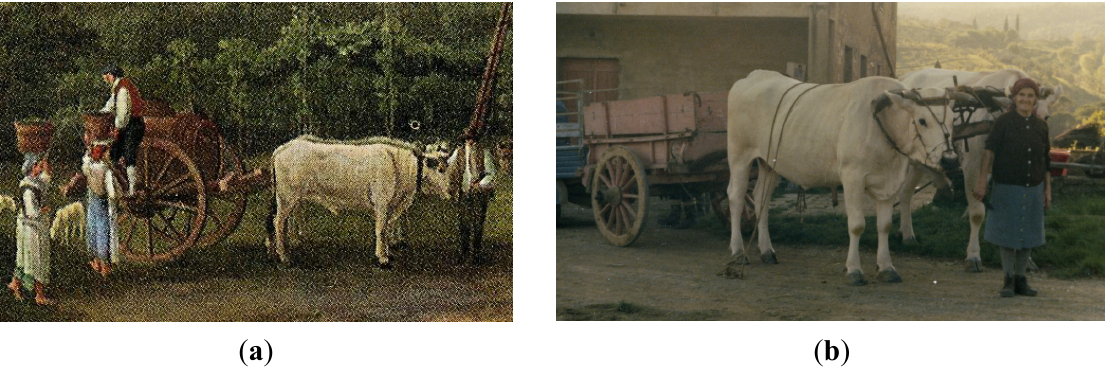
Figure 18. Chianina draught cattle. ( a ) The Autumn , Jacob Philipp Hackert, painted ca. 1784 in Italy, detail (Wallraff-Richartz-Museum, Cologne) and ( b ) San Gimignano, 1967 (photograph by Veronica